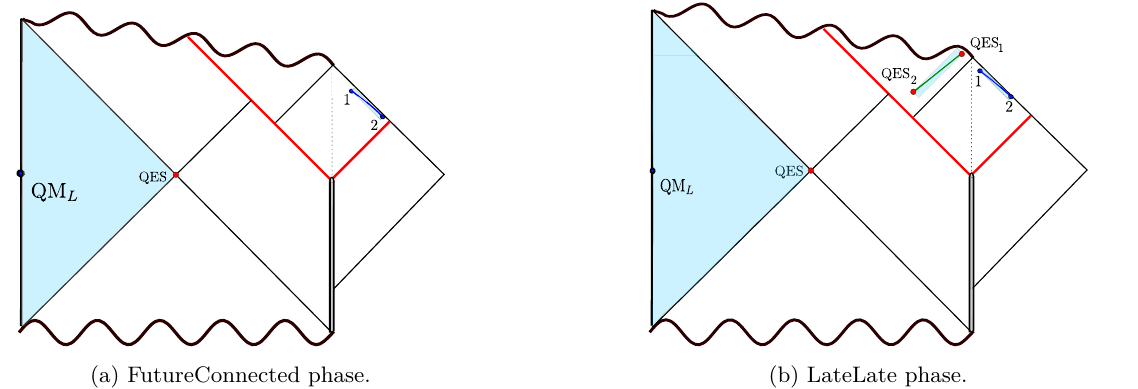
Figure 17. A sketch of the entanglement wedges for the different phases of the entanglement entropy for QM L +finite segment during very late